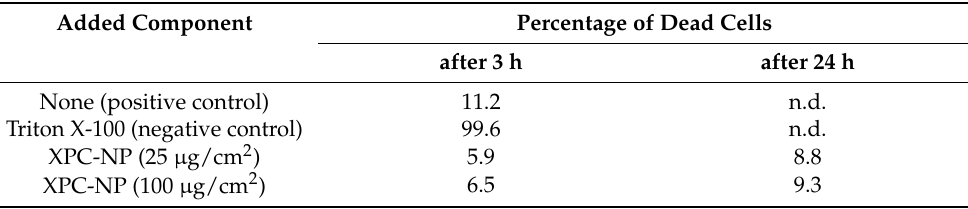
Figure 4. ( a ) Scanning electron microscopy images of nanoparticles (NP) obtained by self-assembling of xylan phenyl carbonate (XPC; degree of substitution of 1.71, initial mass concentration of 4 mg/mL) before and after conversion with amine functionalized dye DY 605 and ethanolamine (blocking reagent). ( b ) Particle sizes and polydispersity indices (PDI) of XPC-NP (degree of substitution of 1.82, initial mass concentration of 4 mg/mL) determined after each individual process step during the functionalization with amine functionalized dye DY 605. Table 2. Results of the cell death assay (SYTOX assay) on the human hypopharyngeal carcinoma